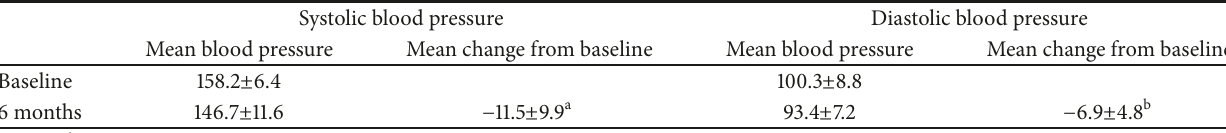
Table 1: Changes in office blood pressure.